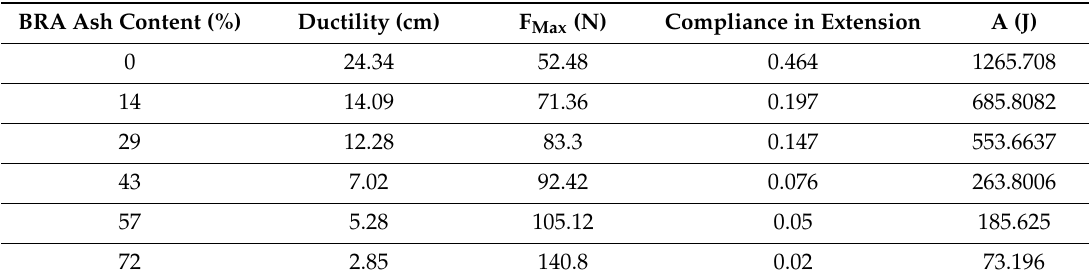
Table 12. Force ductility test result of BRA ash asphalt mortar.